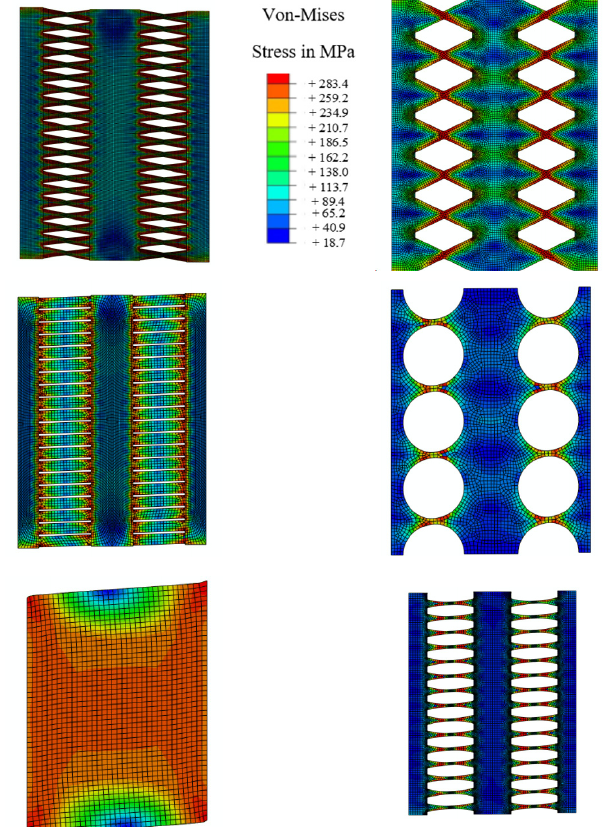
Figure 20. Von-Mises stress for